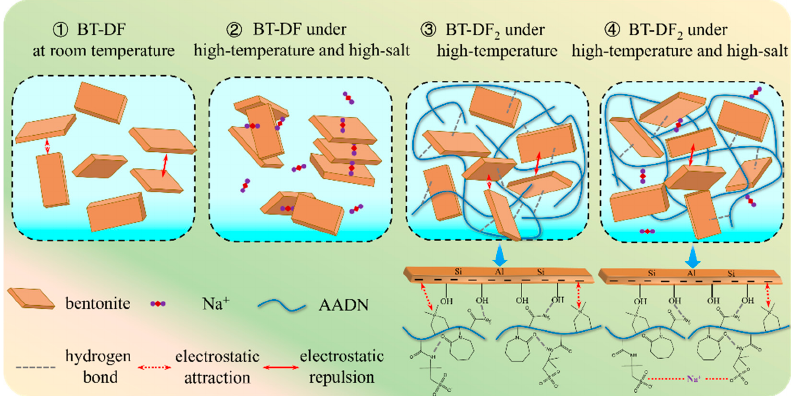
Figure 10. SEM image of the filter cake: ( a 1 , a 2 ) BT-DF; ( b 1 , b 2 ) BT-DF + 20 wt% NaCl; ( c 1 , c 2 ) BT-DF 2 and ( d 1 , d 2 ) BT-DF 2 + 20 wt%